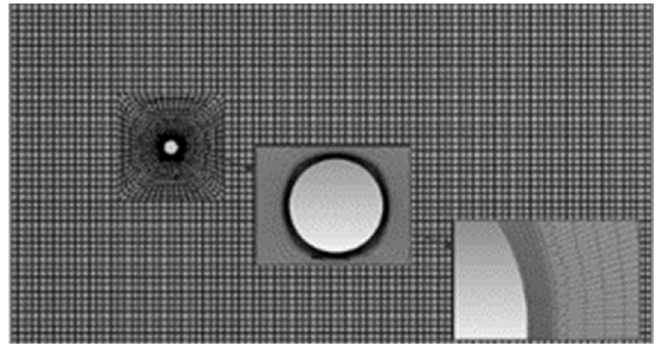
Figure 4. Computational mesh.